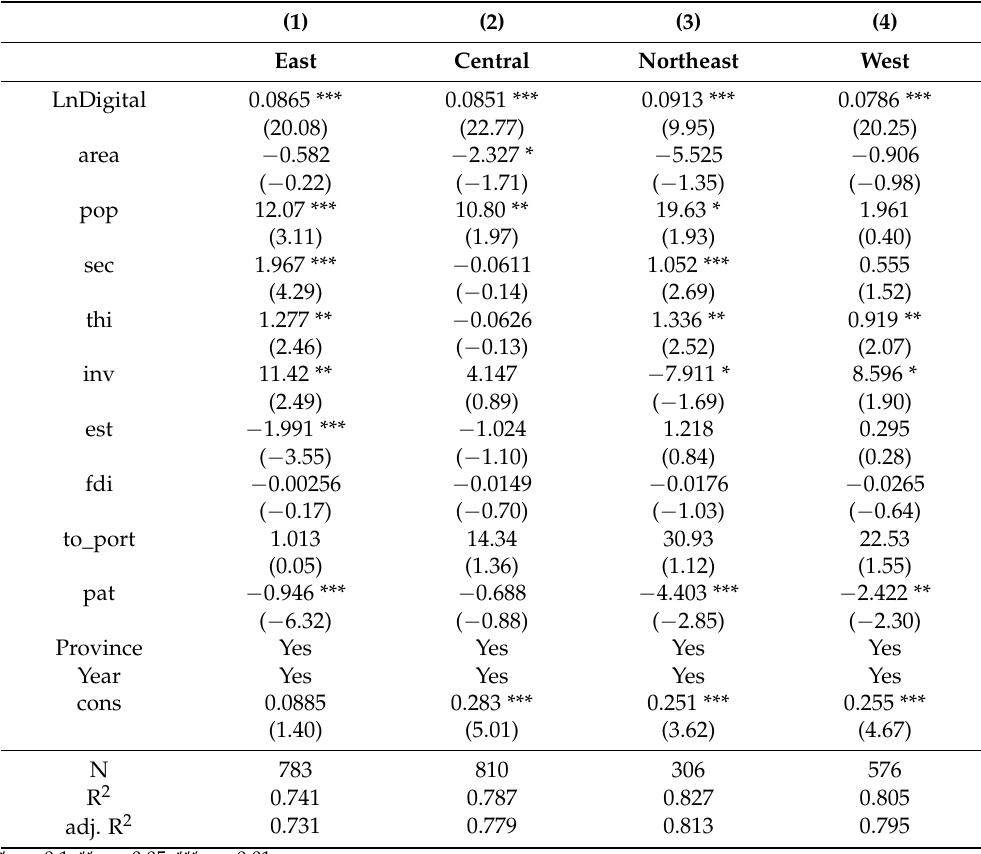
Table 8. Influence of Degree of Digital Economy on Green Productivity: Regional